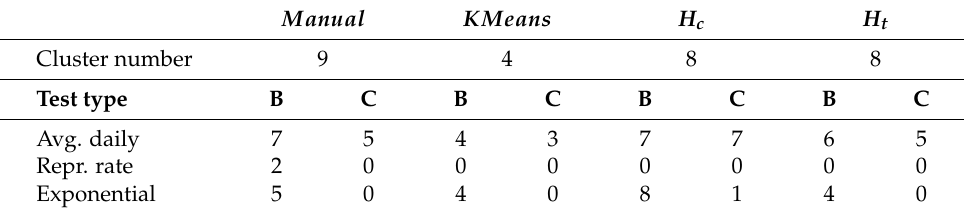
Table 10. Statistical significance of different feature groupings. The groupings were done either manually or with K-means or hierarchical clustering ( H c —using absolute correlation as distance, H t —using Euclidian distance between values of different feature values directly). The label B stands for the base statistical test, while C for the test with the applied correction.